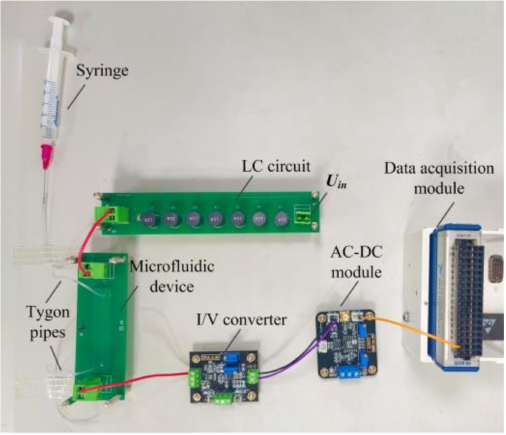
Figure 6. The photo of the experimental